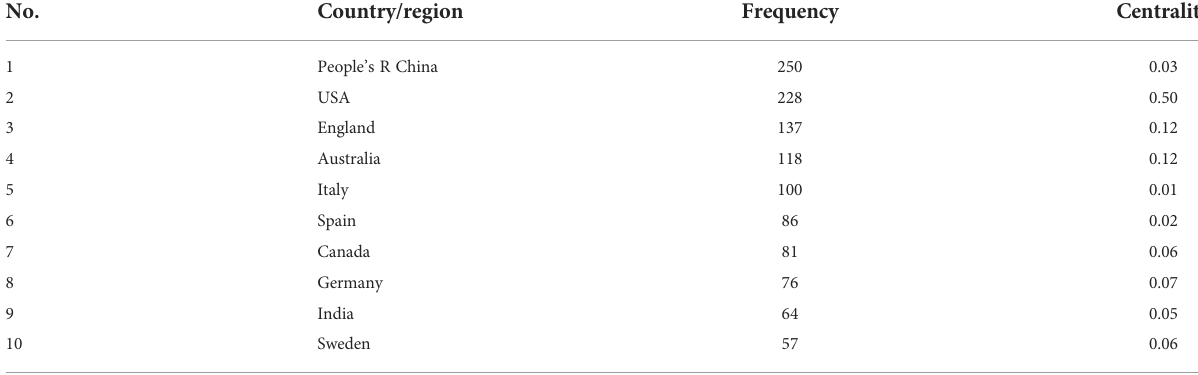
TABLE 4 The top 10 countries based on frequency.